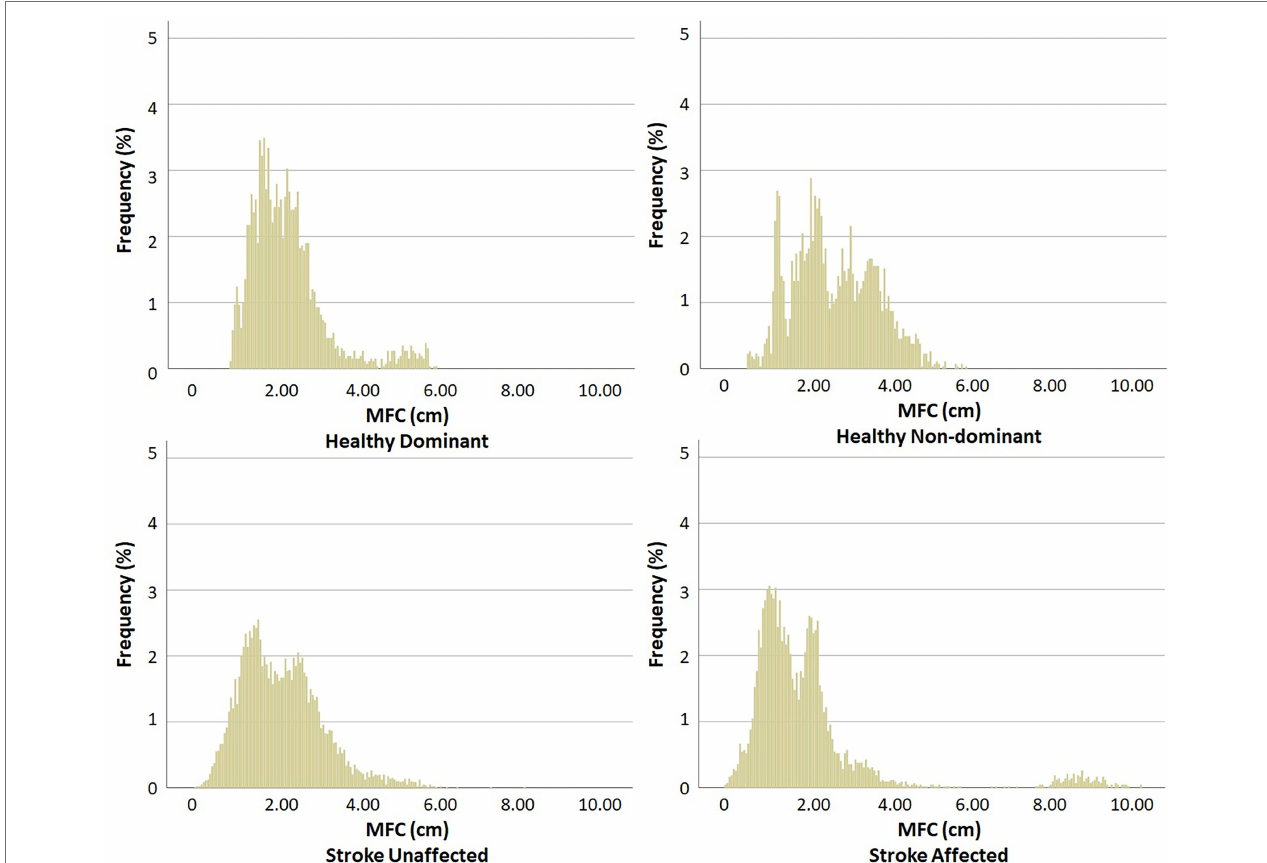
FIGURE 2 | MFC histogram. Stronger vs. Weaker: Healthy (dominant vs. non-dominant) and Stroke (unaffected vs.